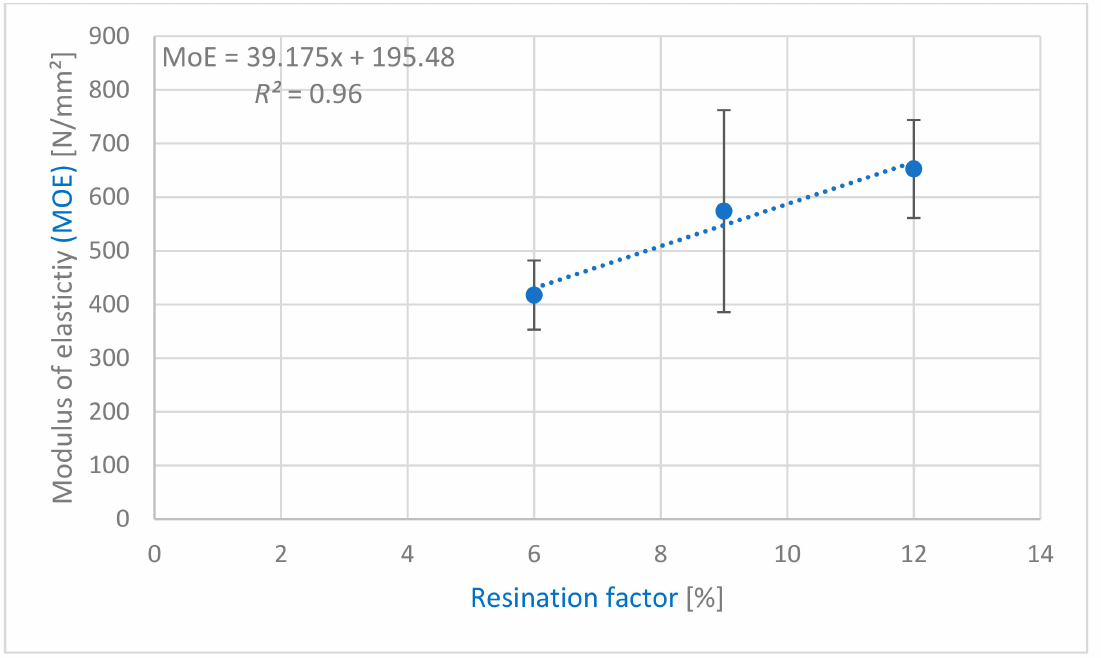
Figure 5. Regression model of resination factor (6%, 9%, and 12% UF), and modulus of elasticity (MOE) of the light particleboard with